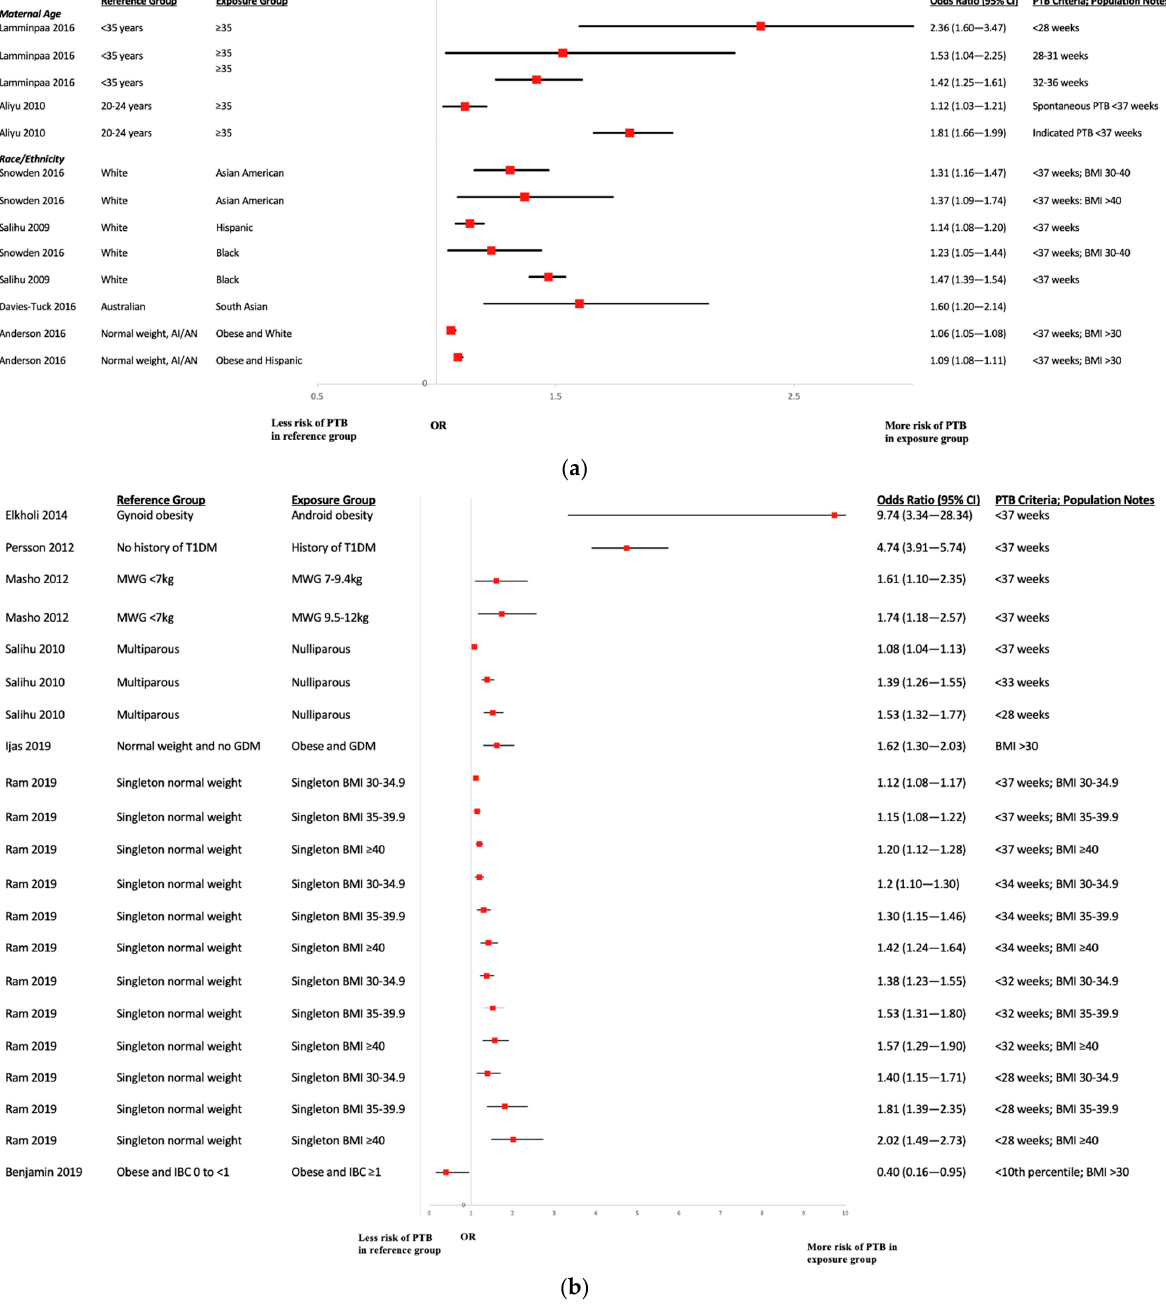
Figure 5. ( a ) Pre-term Birth Age and Race. Acronyms: BMI = body mass index; PTB = preterm birth; AI/AN = American Indian/Alaskan Native; CI = confidence interval. ( b ) Pre-term Birth Risk Factors. Acronyms: BMI = body mass index; PTB = preterm birth; T1DM = type 1 diabetes mellitus; MWG = maternal weight gain; GDM = gestational diabetes mellitus; IBC = interpregnancy-BMI change; CI = confidence interval.